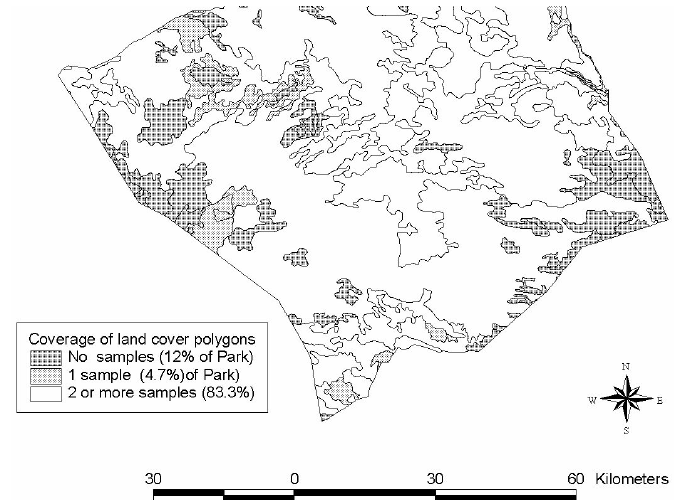
Fig. 8. Sampling intensity across original land cover polygons in the Parque Nacional de Banhine. Polygons with no or only one sample indicate greater uncertainty as to their correct landscape